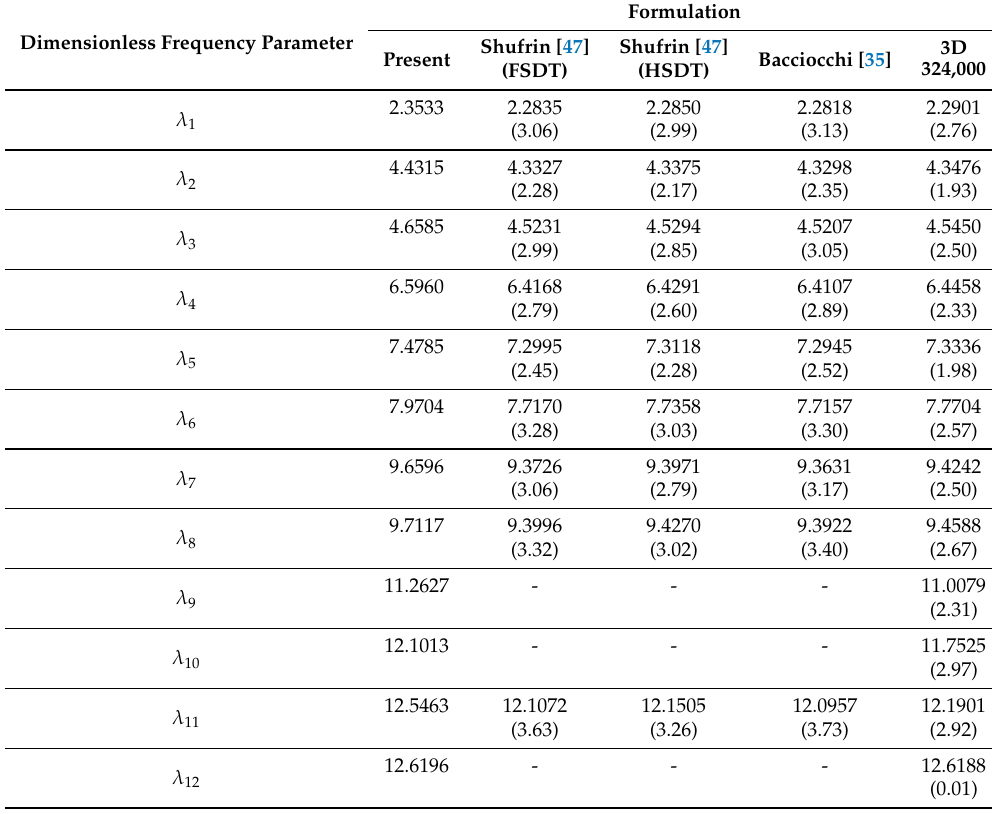
Table 12. Comparison of results for a square plate of ratio b / h 0 = 20, parabolic variation and CCCC boundary